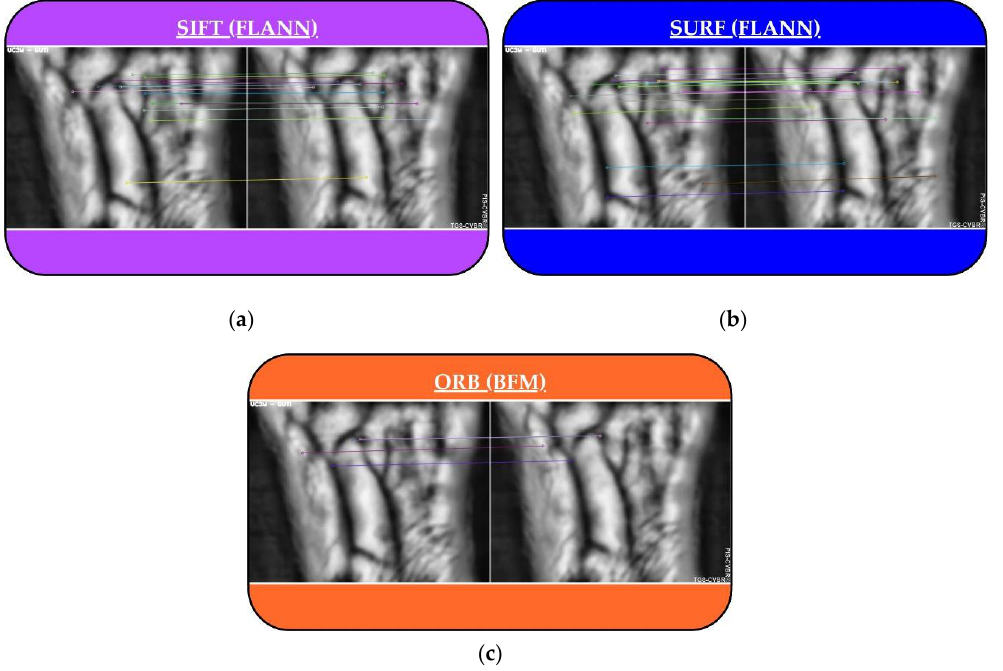
Figure 5. PIS-CVBR ® : feature matching for User 0. Correct matching points for two samples of User 0 with the three feature extraction algorithms: ( a ) SIFT ® (with Fast Library for Approximate Nearest Neighbors (FLANN)). ( b ) SURF ® (with FLANN). ( c ) ORB (with Brute Force Matcher (BFM)).